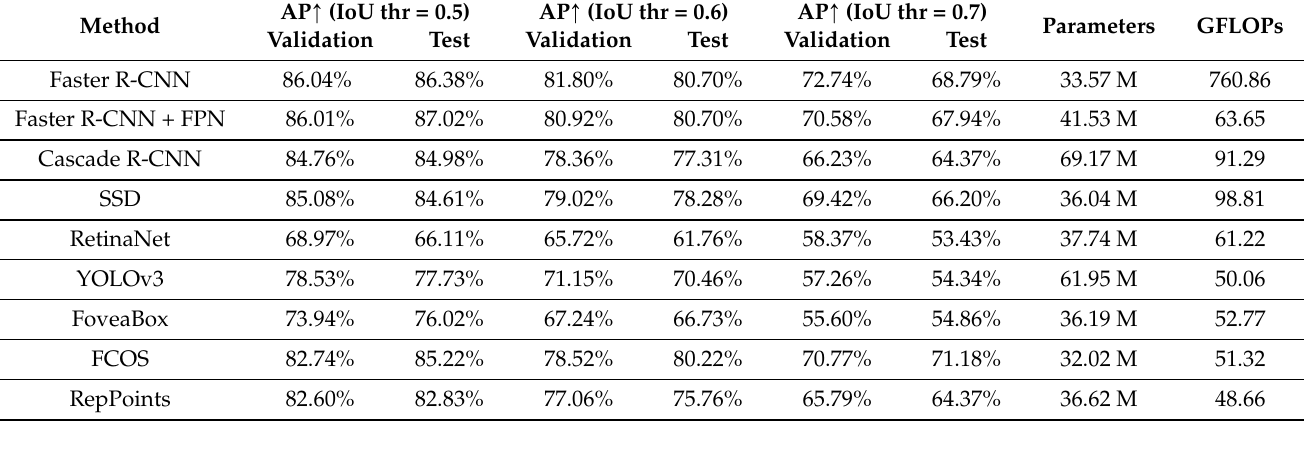
Table 1. Average precision (AP) of nine CNN models on the validation and test sets with their parameters and GFLOPs. IoU thr is the IoU threshold during model evaluation.